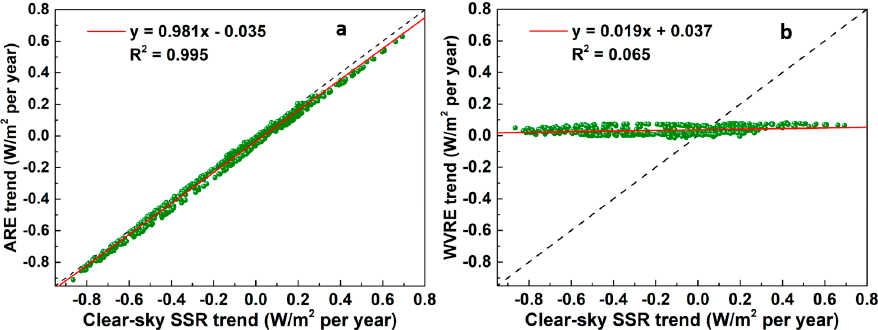
Figure 14. Linear regressions between clear-sky SSR trend and ( a ) ARE trend and ( b ) WVRE trend in northern China during